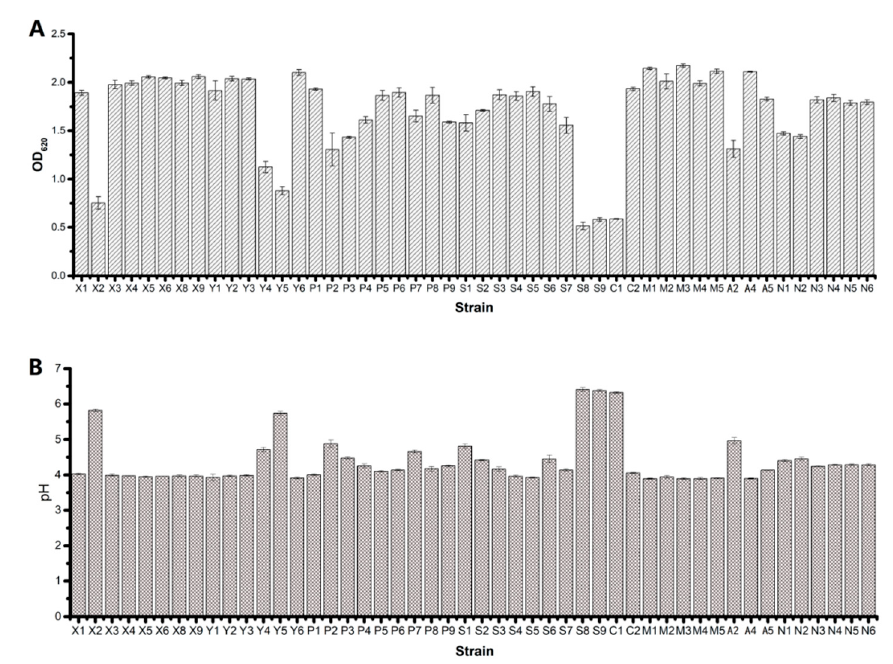
Figure 2. The growth ( A ) and pH ( B ) of the strains incubated in MRS medium. Table 1. The acid production of lactobacillus bacteria cultivated in MRS medium.